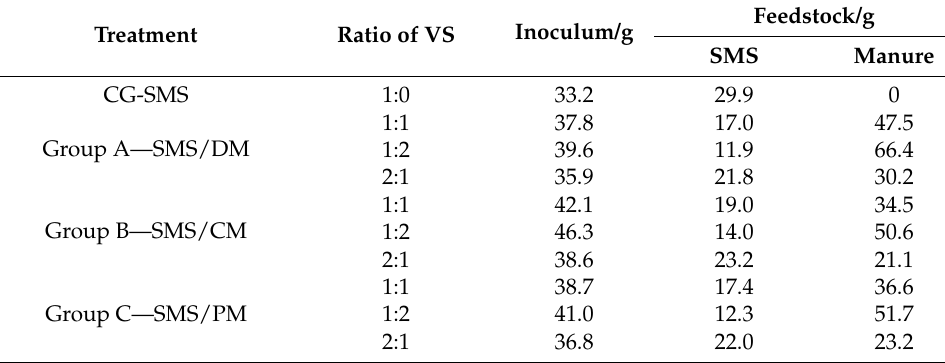
Table 2. Feed number of raw materials and inoculum.